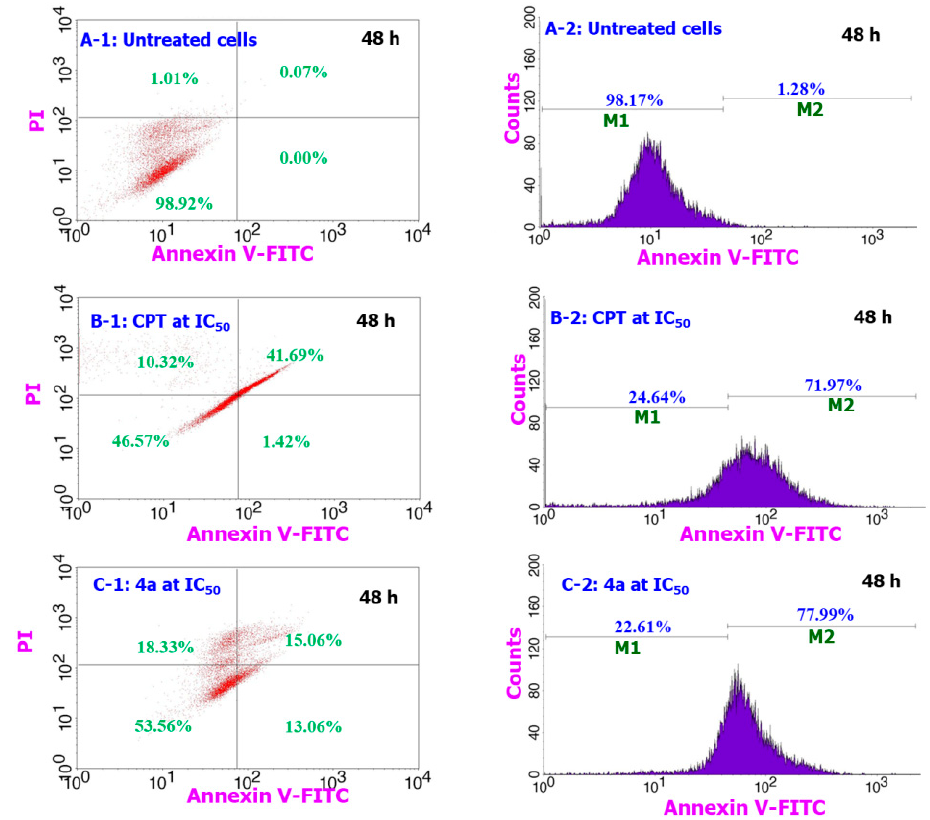
Figure 6. Comparison of apoptosis studies for the compound 4a ( B ) with that of positive ( C ) and negative controls ( A ) for the A549 cells over the 48 h incubation period.